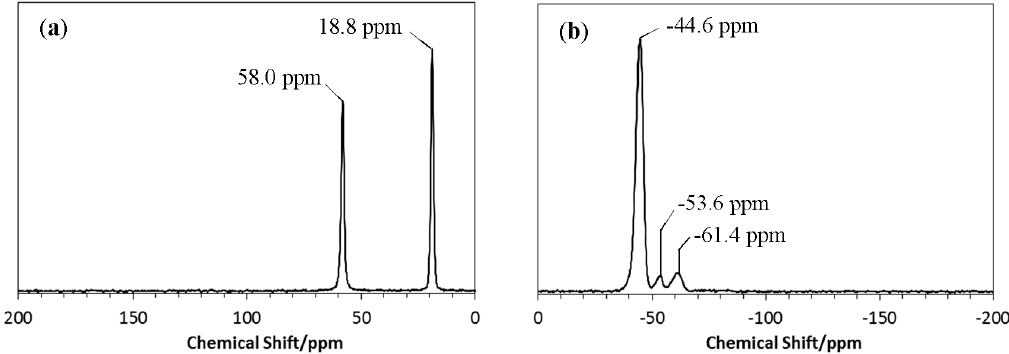
Figure 2. ( a ) 13 C- and ( b ) 29 Si-NMR spectra of EtOSZ.